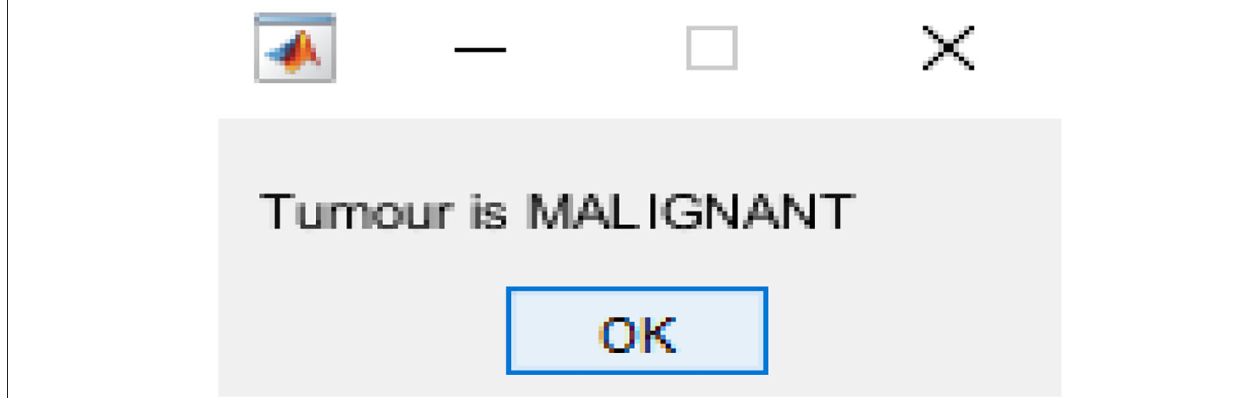
FIGURE 5 | Classification output.